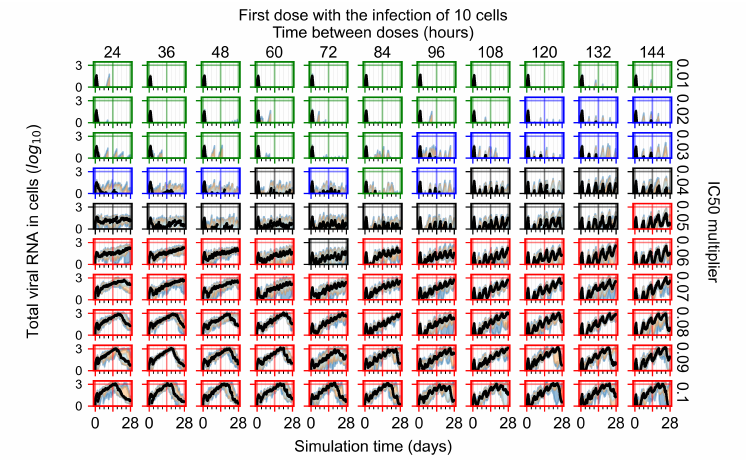
Figure A81. Diffusive cytokine amount for eight replicas of the treatment simulation, Y axis in log scale, and exponent values as tick marks.